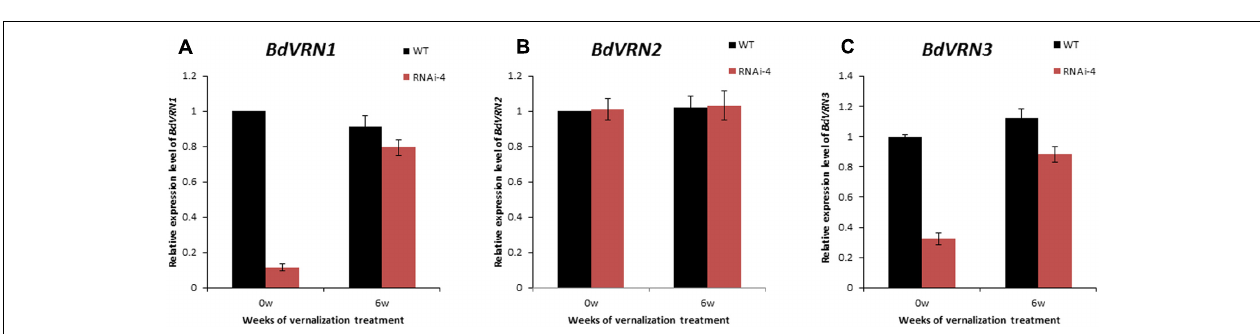
FIGURE 3 | (A) Wild type (WT) (left) and BdVRN1 RNAi mutant plant (right) 7 weeks after seed germination. (B) Real-Time RT-PCR analysis of the BdVRN1 expression level in the WT, knockdown mutants of BdVRN1 RNAi-4 and RNAi-12. (C) Average number of days required for flowering for the WT Bd21 and RNAi mutants with or without a 6-week vernalization treatment. Four-week-old seedlings (30 plants for each accession) were either not vernalized or vernalized for 6 weeks at 4 ◦ C and 8/16 h (day/night) in a growth chamber. After the vernalization treatment, plants were transferred to a greenhouse (25 ◦ C, 16/8 h day/night). NF denotes non-flowering phenotype. The average number of days to flowering indicates the number of days passed before flowering occurs following a vernalization treatment. Error bars represent the standard deviation from independent plants.